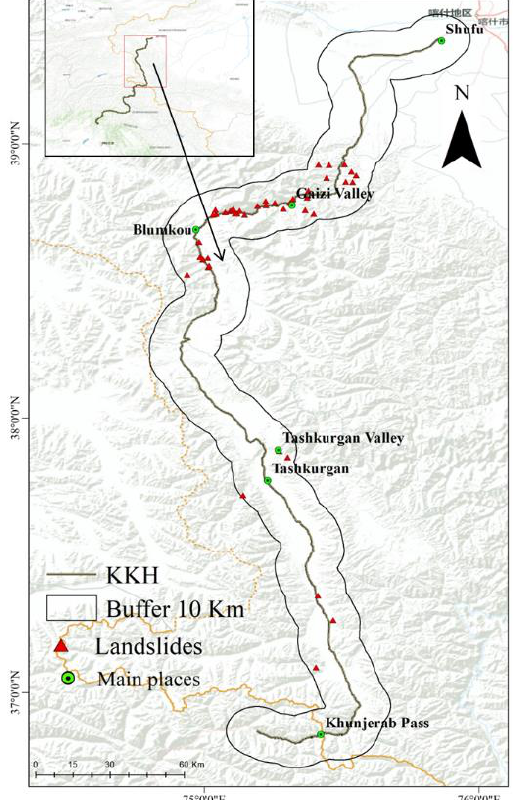
Figure 1. The study area and distribution of landslides (The yellow line is the border between China and Pakistan. The red line on the up-right is the border of Chinese provinces.).